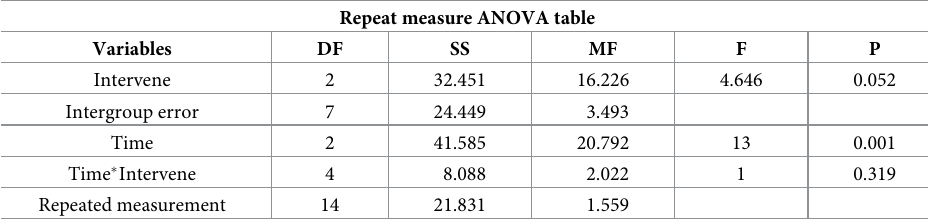
Table 5. Statistical scale of modified mNSS score.